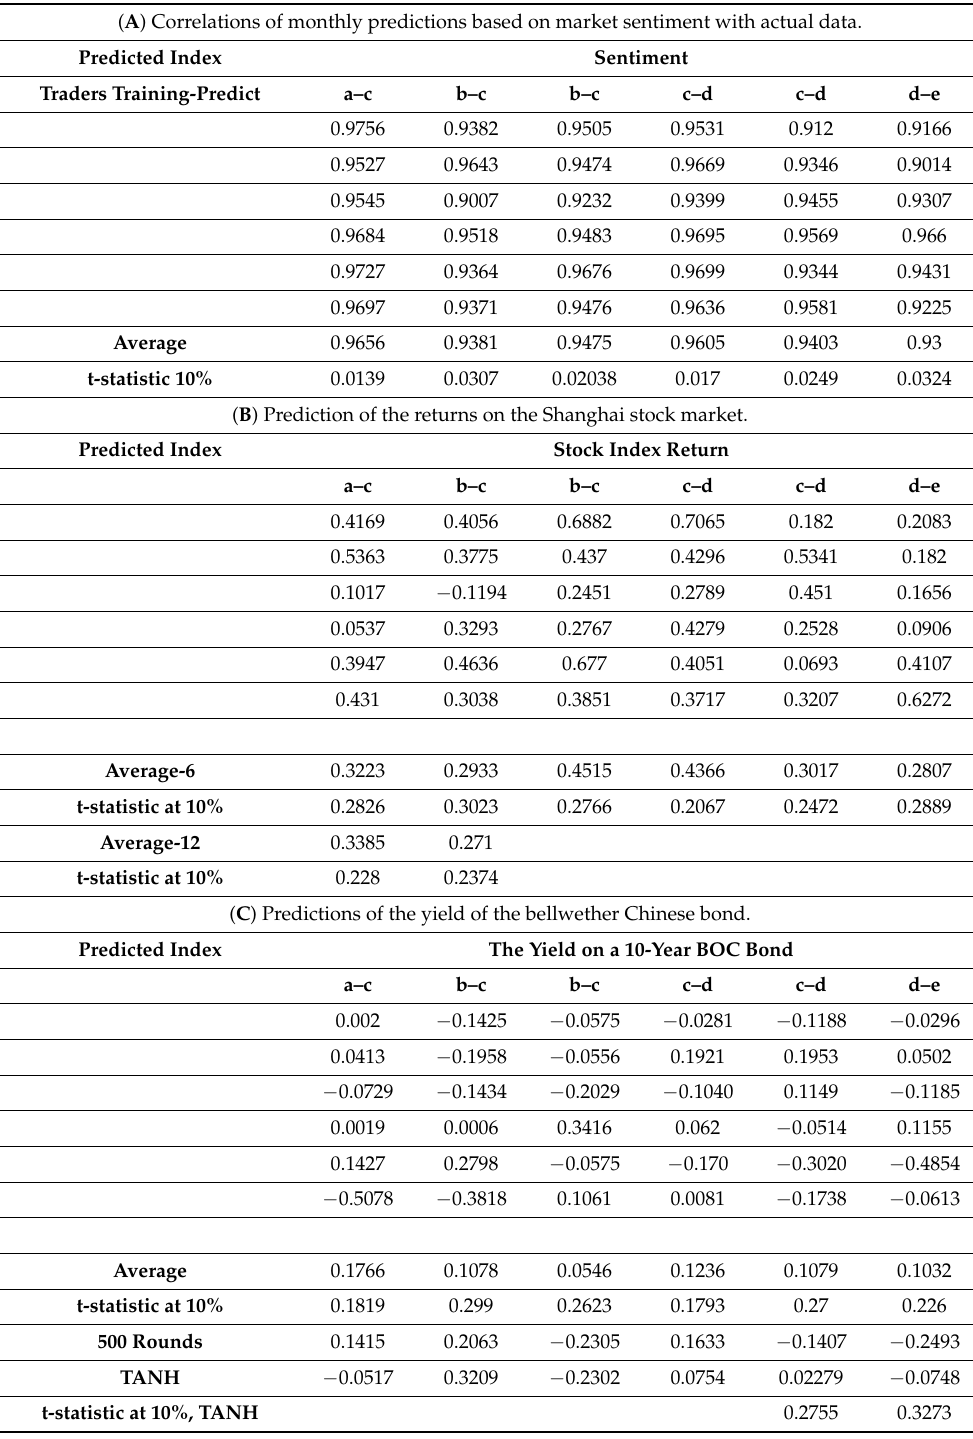
Table 4. Correlation of predictions of the three indexes. Traders “a” and “b” were designated as informed about the index. The first two columns include informed traders in both training and prediction samples. The second pair of columns include data from an informed trader only in the training sample. The third pair of columns does not have an informed trader at all. For comparisons, we show the results obtained by a single 500 round and by changing ReLU into the TANH perceptron function. The lower left rectangle indicates data obtained from six TANH